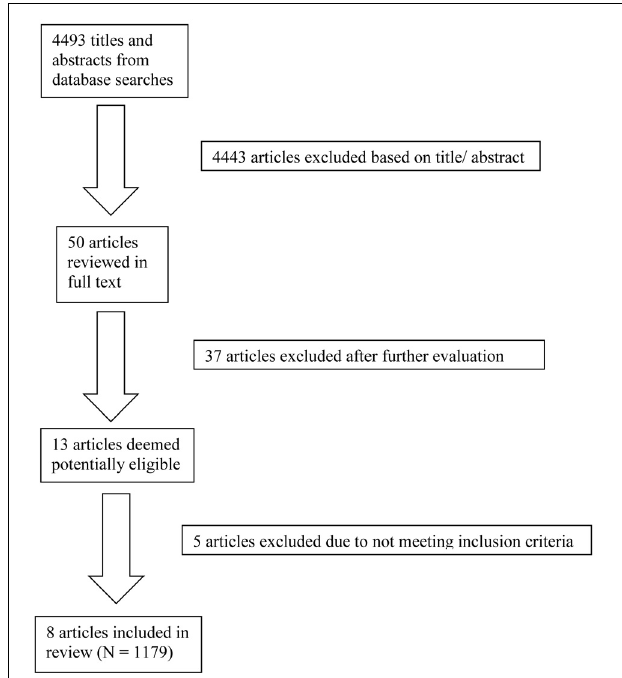
FIGURE 1 | Flow diagram of review